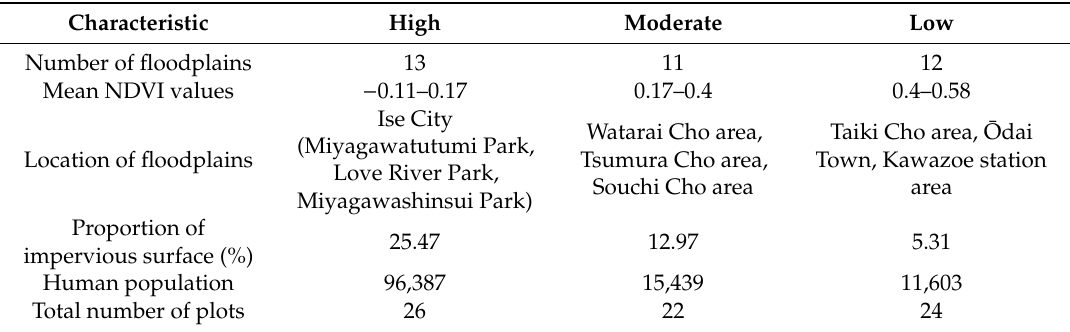
Table 1. Number and location of floodplain areas selected at di ff erent degradation levels. Notes: the information of the population was derived from the Mie Prefectural